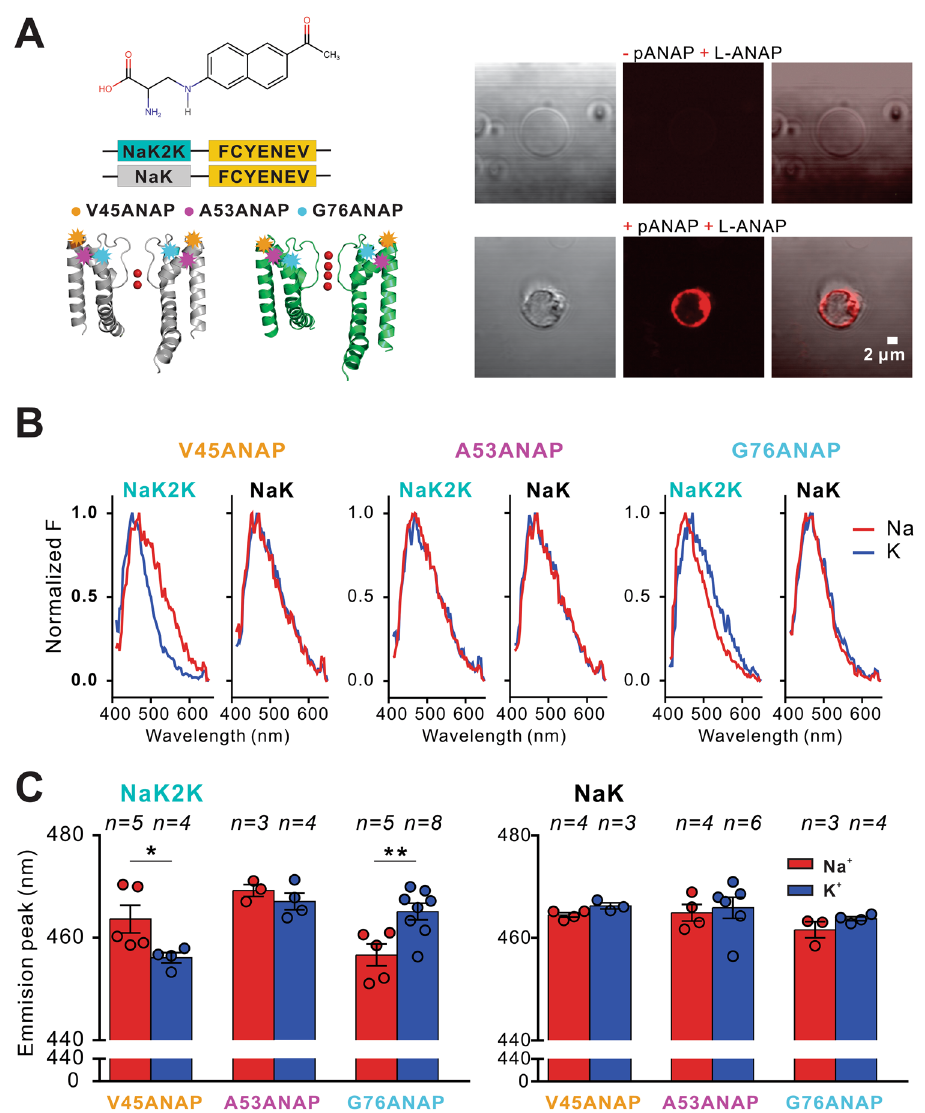
Fig. 3 | NaK2K SF conformational changes in cellular membranes. A Chemical structureofANAPinsertedusingtheambercodonatpositionsV45(TM1),A53(PH) and G76 (TM2) in NaK and NaK2K (PBD 3E8H and 3OUF, respectively, with C-terminal FCYENE sequence motif expressed in CosM6 cells ( left ) and repre- sentative (for at least n =3 vesicles in each case) images of negative control giant plasma membrane vesicles (GPMVs) where the pANAP vector was not added, and positiveGPMVsexpressingANAP-incorporatedNaK( right ).PseudocolorsforANAP were used. B Representative emission spectra (red, 150mM NaCl bath solution;